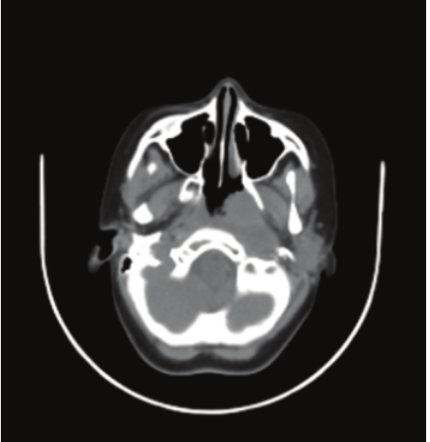
Figure 1: In the contrasted neck MRI, there was 3 × 3 cm axial size, hyperintense in T2 weighted, left parapharyngeal space occupying lesion on the left infratemporal fossa adjacent to the medial-inferior border.